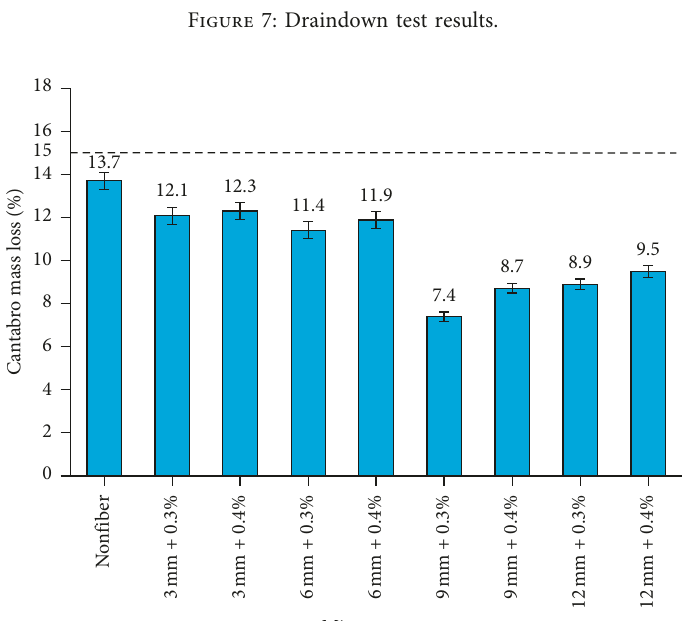
Figure 7: Draindown test results.